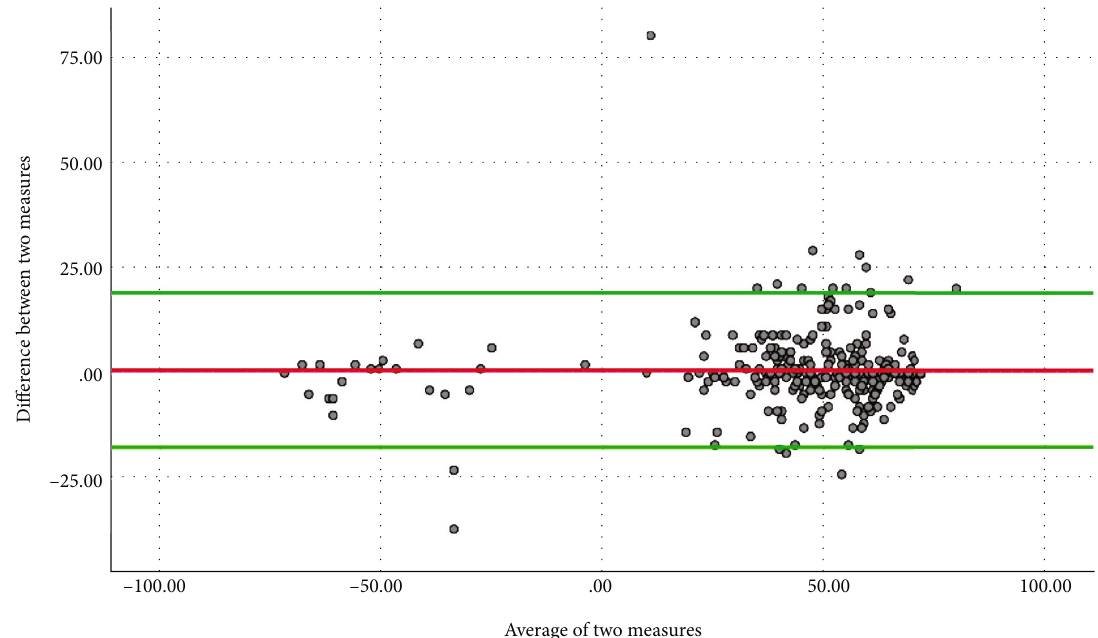
Figure 2: Bland-Altman